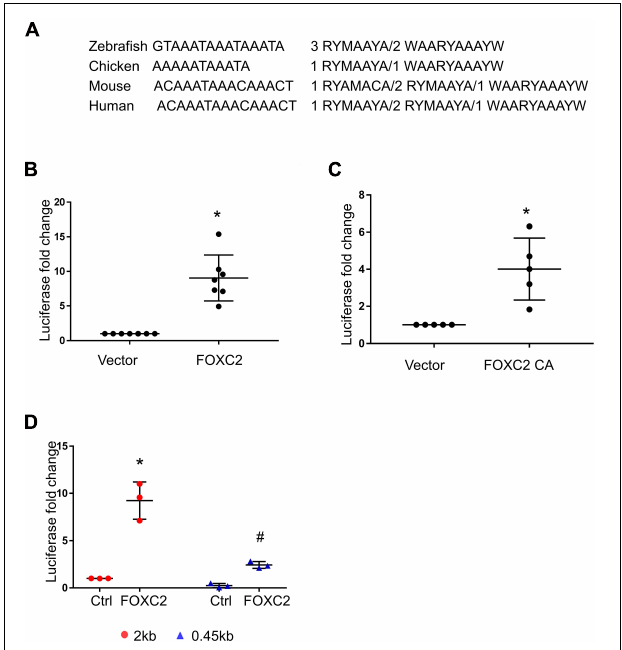
FIGURE 2 | Luciferase assay demonstrates that FOXC2 promoter is activated by FOXC2 WT and FOXC2 CA in HPMEC-Im. (A) Overlapped FBEs in Zebrafish, Chicken, mouse and human in 2 kb FOXC2 upstream region. (B,C) 2 kb DNA upstream sequence of human FOXC2 transcriptional start site (TSS) was cloned into pGL4.10 (luc2) and co-transfected with expression plasmids containing FOXC2 CA and FOXC2 WT, respectively. (B) FOXC2 WT overexpression stimulated luciferase reporter activity. n = 7 per group; * p < 0.001. (C) FOXC2 CA increased luciferase activity. n = 5 per